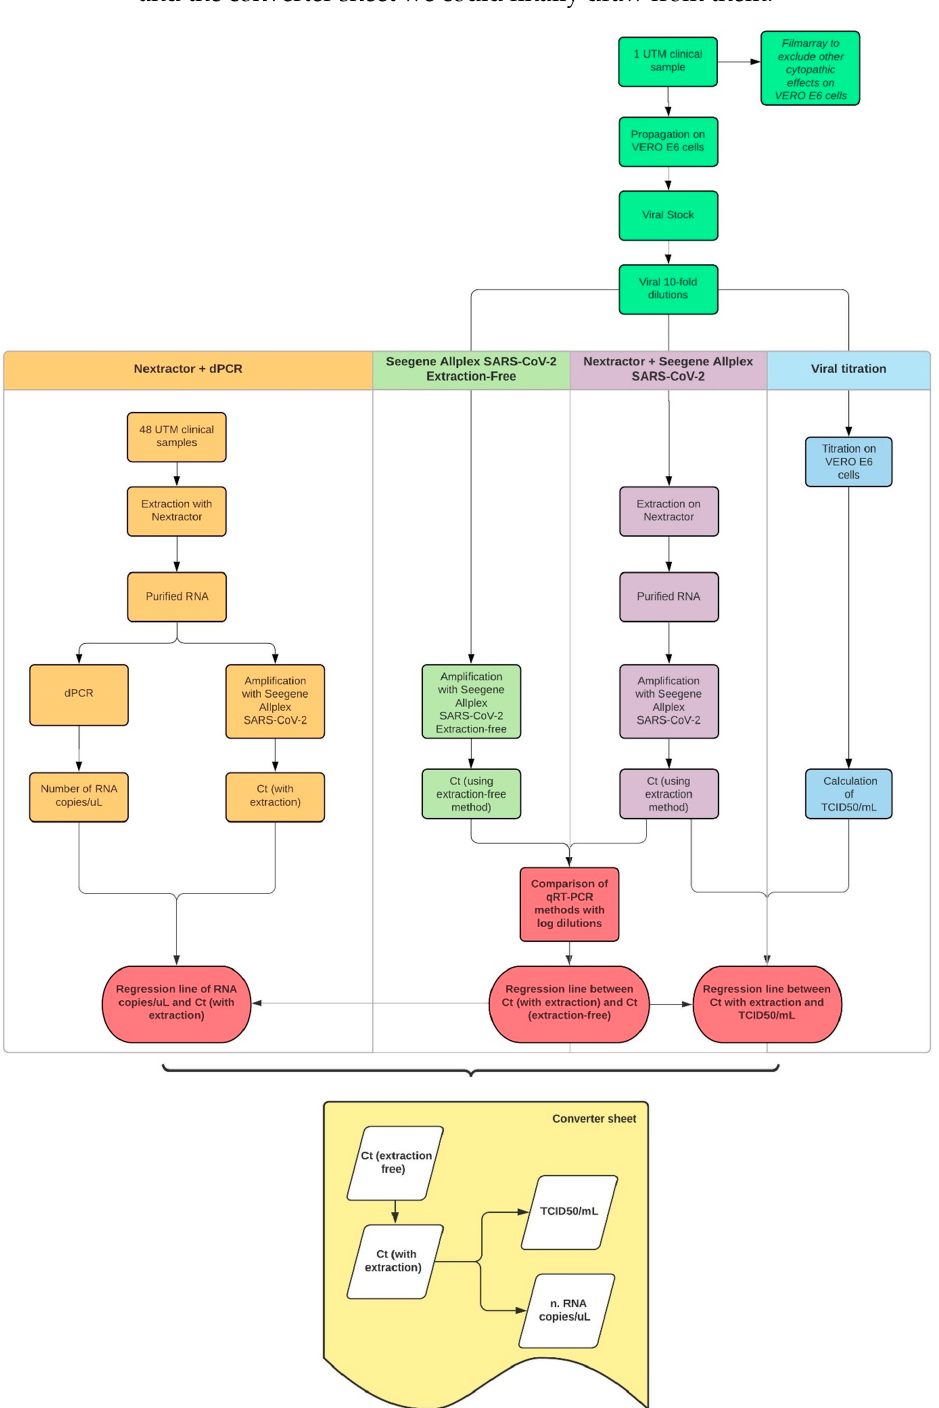
Figure 6. The workflow explaining the procedures and protocols used to correlate our results and obtain the converter sheet, the aim of the entire experiment.